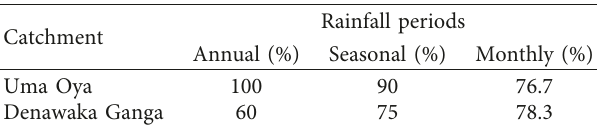
Table 8: Comparison percentages for two catchments in different rainfall